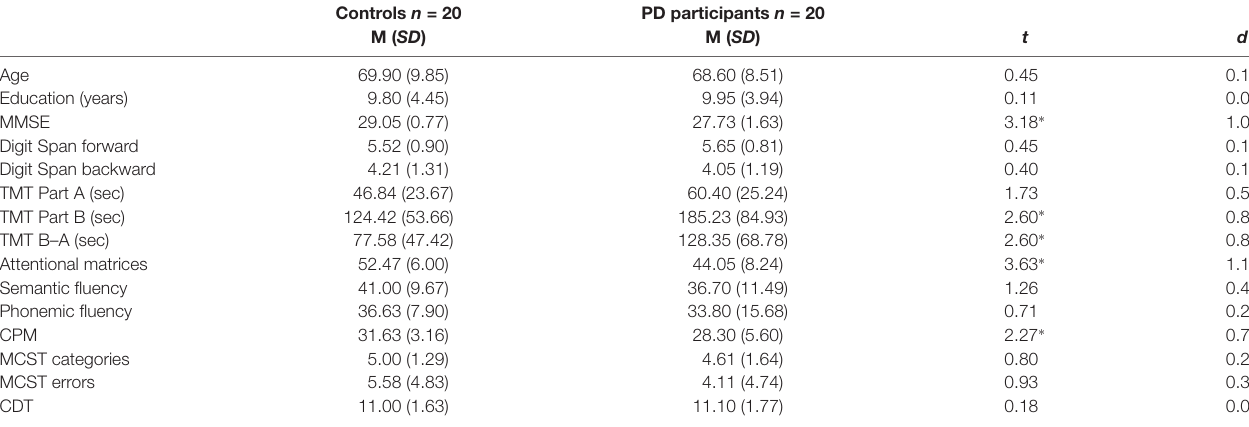
TABLE 1 | Descriptive statistics (mean and standard deviation) for controls and Parkinson’s disease (PD) participants; t and d values are also